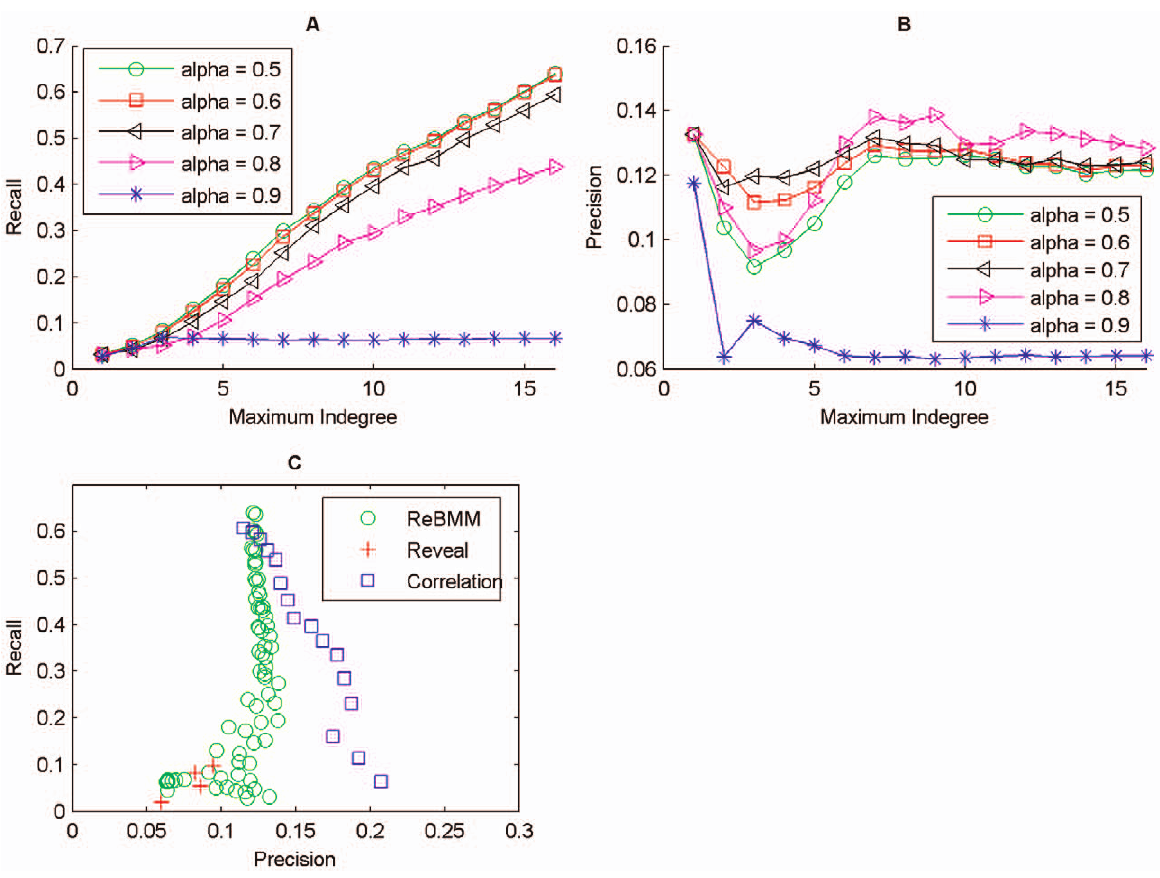
Figure 12. Reconstruction of network for the cdc28 experiments of the yeast cell cycle microarray data. Figure A shows the recall against maximum indegree for ReBMM for different a values. Figure B illustrates the plot for precision. The comparison of ReBMM, correlation and REVEAL is displayed in Figure C. Here the performance of correlation is better than the rest of the methods.